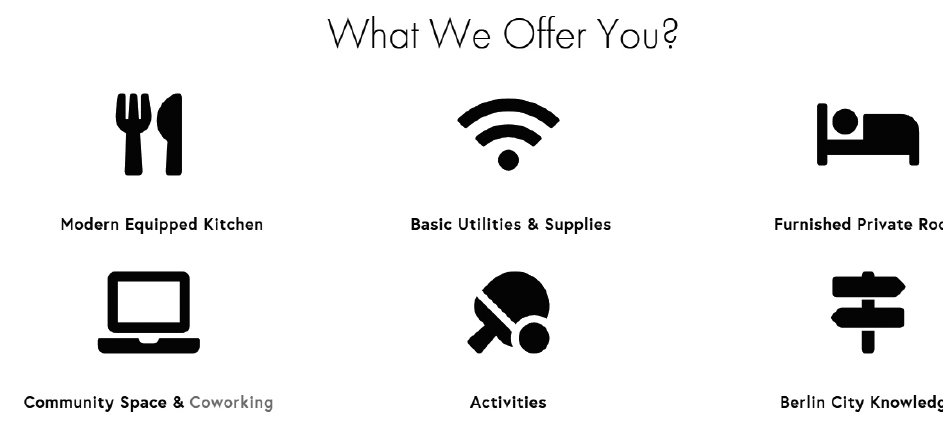
Figure 17. Usual services included in co-living contracts, Berlin. Source: Happy Pigeons